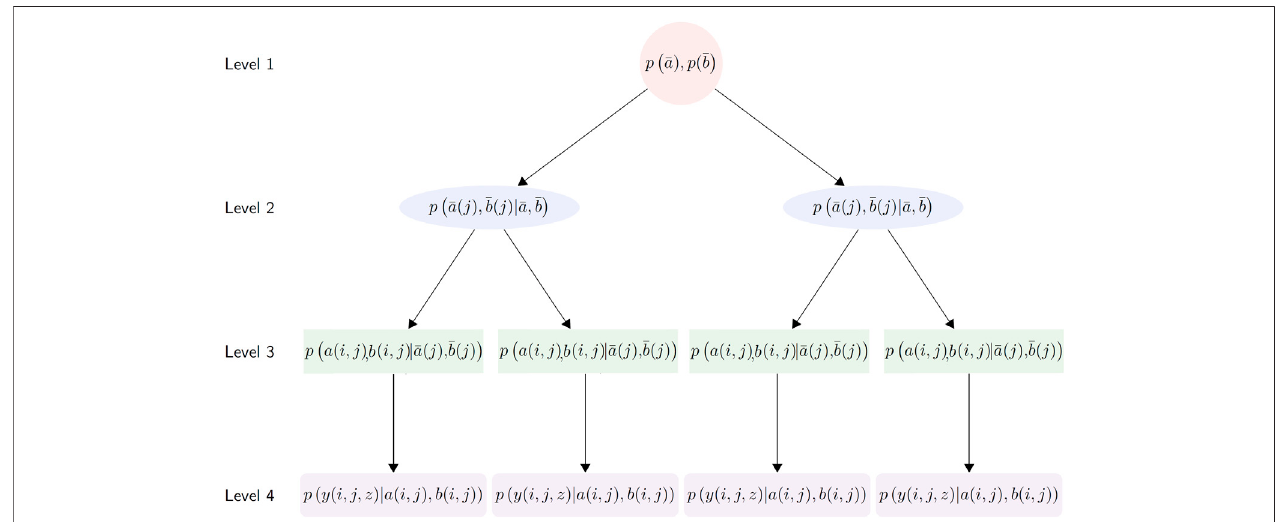
FIGURE2| Thedirectedacyclicgraph(DAG)structureoftheBayesianhierarchicalmodel.Atlevel(1),theglobal-levelparametersdescribethemeanpro fi leacross all biomes and stations. At level (2), the biome-level parameters are sampled conditional on the global level parameters in level (1). Level (3) samples parameters at the station-level of analysis from the biome-level distribution. Level (4) is the data-level of analysis, which constitutes the likelihood function of the observations, where the probability of the individual observations is evaluated conditional on the hierarchical network of parameters sampled previously.